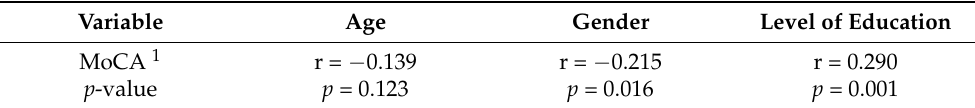
Table 3. Correlation analyses between MoCA and age, gender and level of education. Variable Age Gender Level of Education